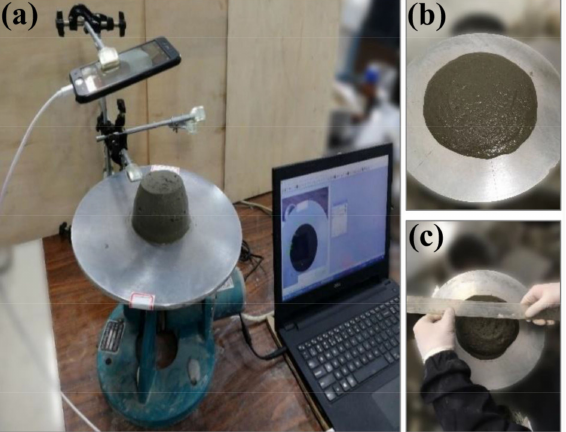
Figure 6. The fluidity test system: ( a ) the shooting and image transmission system, ( b ) the sample on the flow table and ( c ) the measurement of fluidity value.